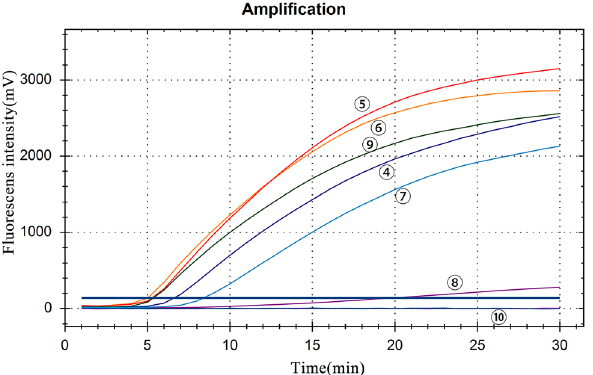
Figure 2. Primer screening results of RT-RAA. ④ – ⑨ : pairs of primers, ⑩ : negative control. The fluorescens intensity of the curve: ⑤ : 3153 mV, ⑥ : 2858 mV, ⑨ : 2559 mV, ④ : 2517 mV, ⑦ : 2131 mV, ⑧ :280